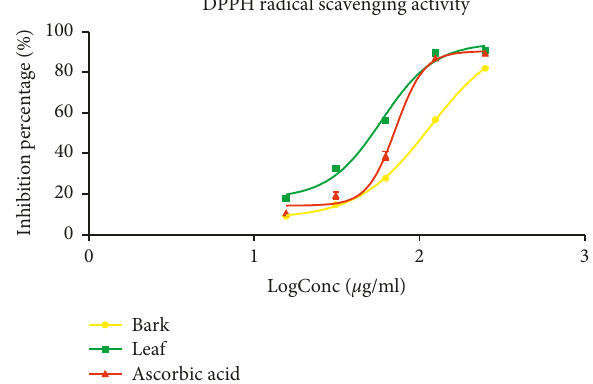
Figure 2: DPPH scavenging activity of the hydro-ethanolic leaf and bark extracts of Psychotria densinervia and ascorbic acid. Values are expressed as mean ± SD ( n �